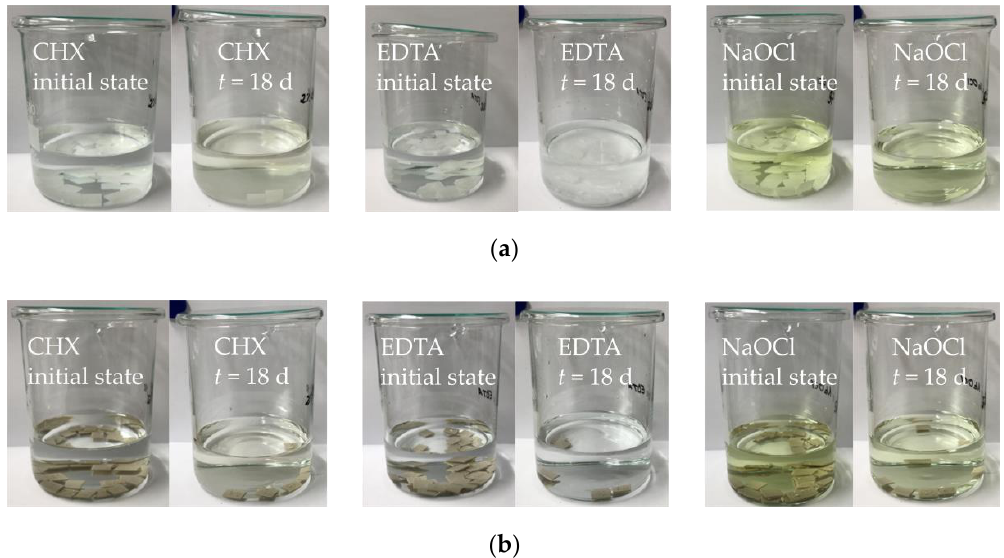
Figure 4. Alteration of irrigants during absorption testing: ( a ) PA6 samples; ( b ) PEEK samples.